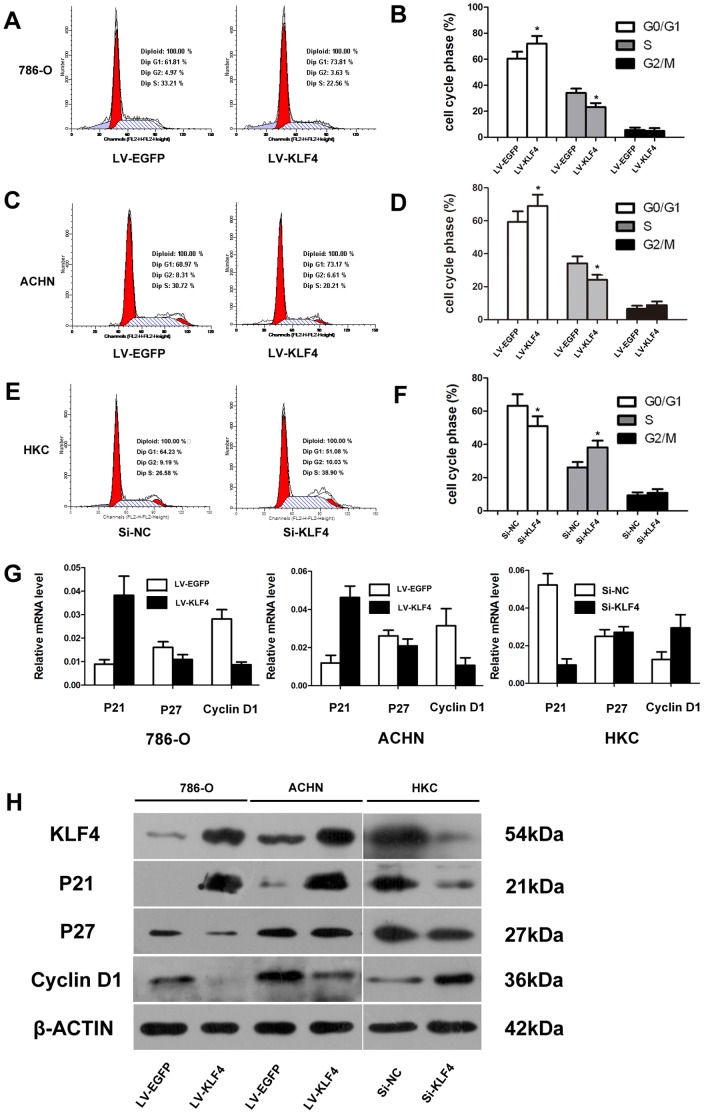
Altered KLF4 expression affected the cell cycle.(A) KLF4 blocked the G1/S phase cell cycle transition of 786-O cells. The percentage of 786-O cells at the G0/G1 phase increased significantly to 73.81% but decreased to 22.56% at the S phase. (B) Quantitative analysis is shown for the cell cycle distribution of LV-EGFP and LV-KLF4 in 786-O cells (*P<0.05 versus the LV-EGFP). (C) KLF4 blocked the G1/S phase cell cycle transition of ACHN cells. The percentage of ACHN cells in G0/G1 phase increased significantly to 73.17% but decreased to 20.21% at the S phase cells. (D) Quantitative analysis is shown for the cell cycle distribution of LV-EGFP and LV-KLF4 in ACHN cells (*P<0.05 versus the LV-EGFP). (E) After KLF4 knockdown, the percentage of HKC cells at the G0/G1 phase significantly decreased from 64.23% to 51.08%, the percentage of cells at S phase increased from 26.58% to 38.90%. (F) Quantitative analysis is shown for the cell cycle distribution of Si-NC and Si-KLF4 in HKC cells (*P<0.05 versus the Si-NC). (G) Real-time PCR results of KLF4, cyclin D1, p21WAF1/CIP1, and p27KIP1 expressions in 786-O and ACHN cells after KLF4 overexpression, the expression level of KLF4, cyclin D1, p21WAF1/CIP1, and p27KIP1 in HKC cells was also investigated after KLF4 knockdown. PPIA was used as a loading control. (H) Western blot analysis results of KLF4, cyclin D1, p21WAF1/CIP1, and p27KIP1 expressions in 786-O and ACHN cells after KLF4 overexpression, western blot analysis was also performed to investigate the expressions of cyclin D1, p21WAF1/CIP1, and p27KIP1 after KLF4 knockdown. β-actin was used as a loading control.